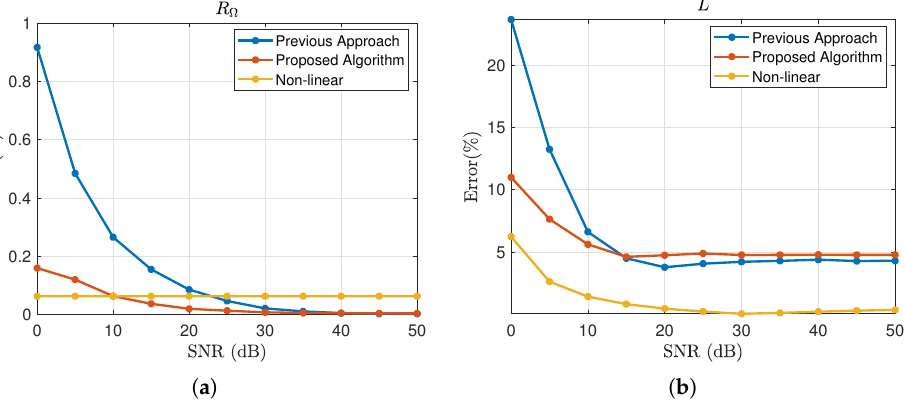
Figure 10. Parameter estimation of the RL Arc. Blue line shows the % error in parameters estimation using previous approach. % error in parameters estimation using the proposed approach and non-linear approach is shown in red and yellow. ( a ) Ohmic resistance. ( b ) Stray